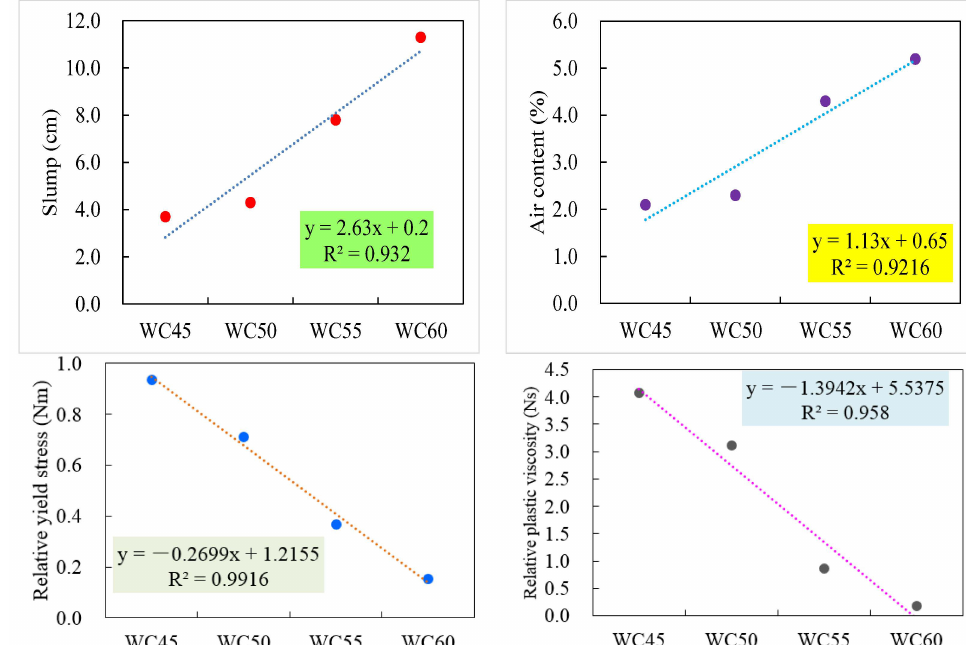
Figure 3. Effect of water–binder ratio on slump, air content, relative yield stress, and viscosity.